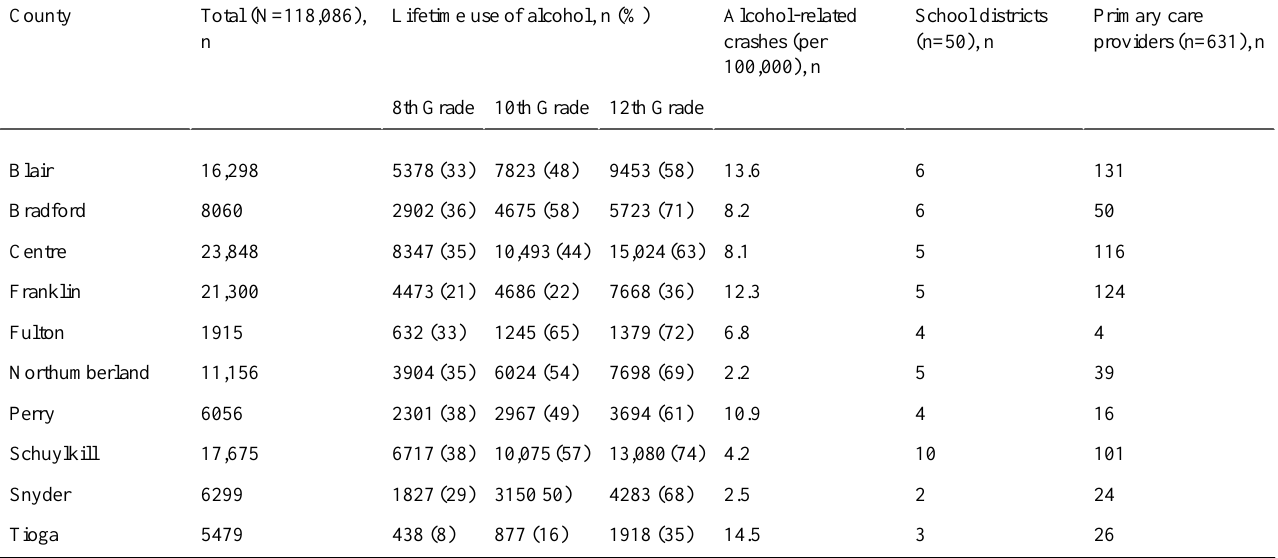
Table 1. Ten rural county catchment area description.